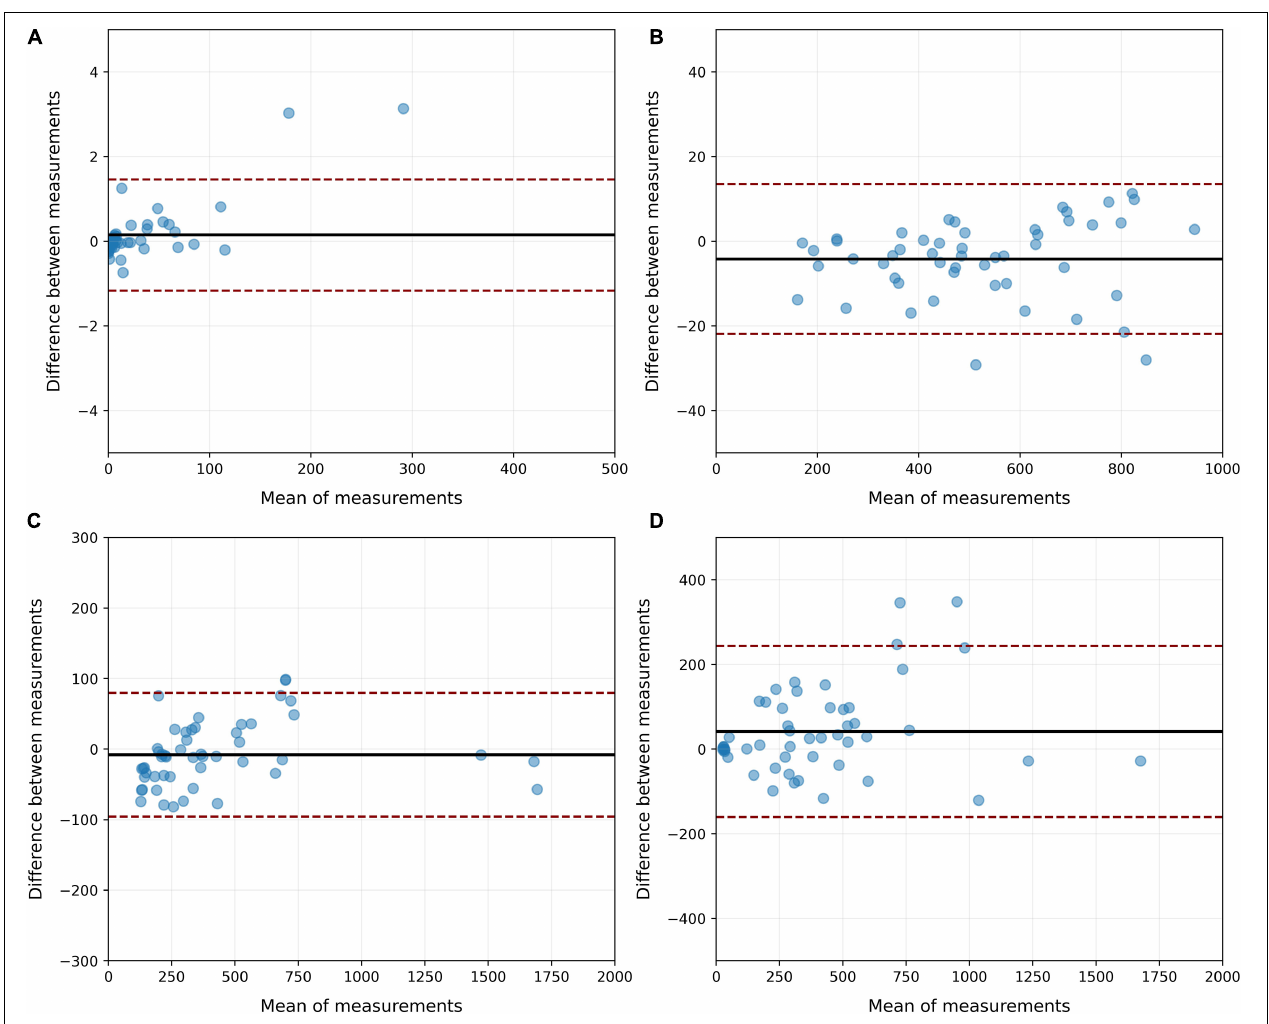
FIGURE 11 | Bland Altman analysis of the agreement between manual and AI-segmentation on the test set when CT-qa was used to measure the over-inflated (A) , well-aerated (B) , poorly inflated (C) and non-aerated (D) tissues on the test set. As shown, biases never exceeded 50 g. The largest CI were, as expected, in the non-aerated tissue, where also for a trained eye is, at times, difficult to distinguish parenchyma from pleural